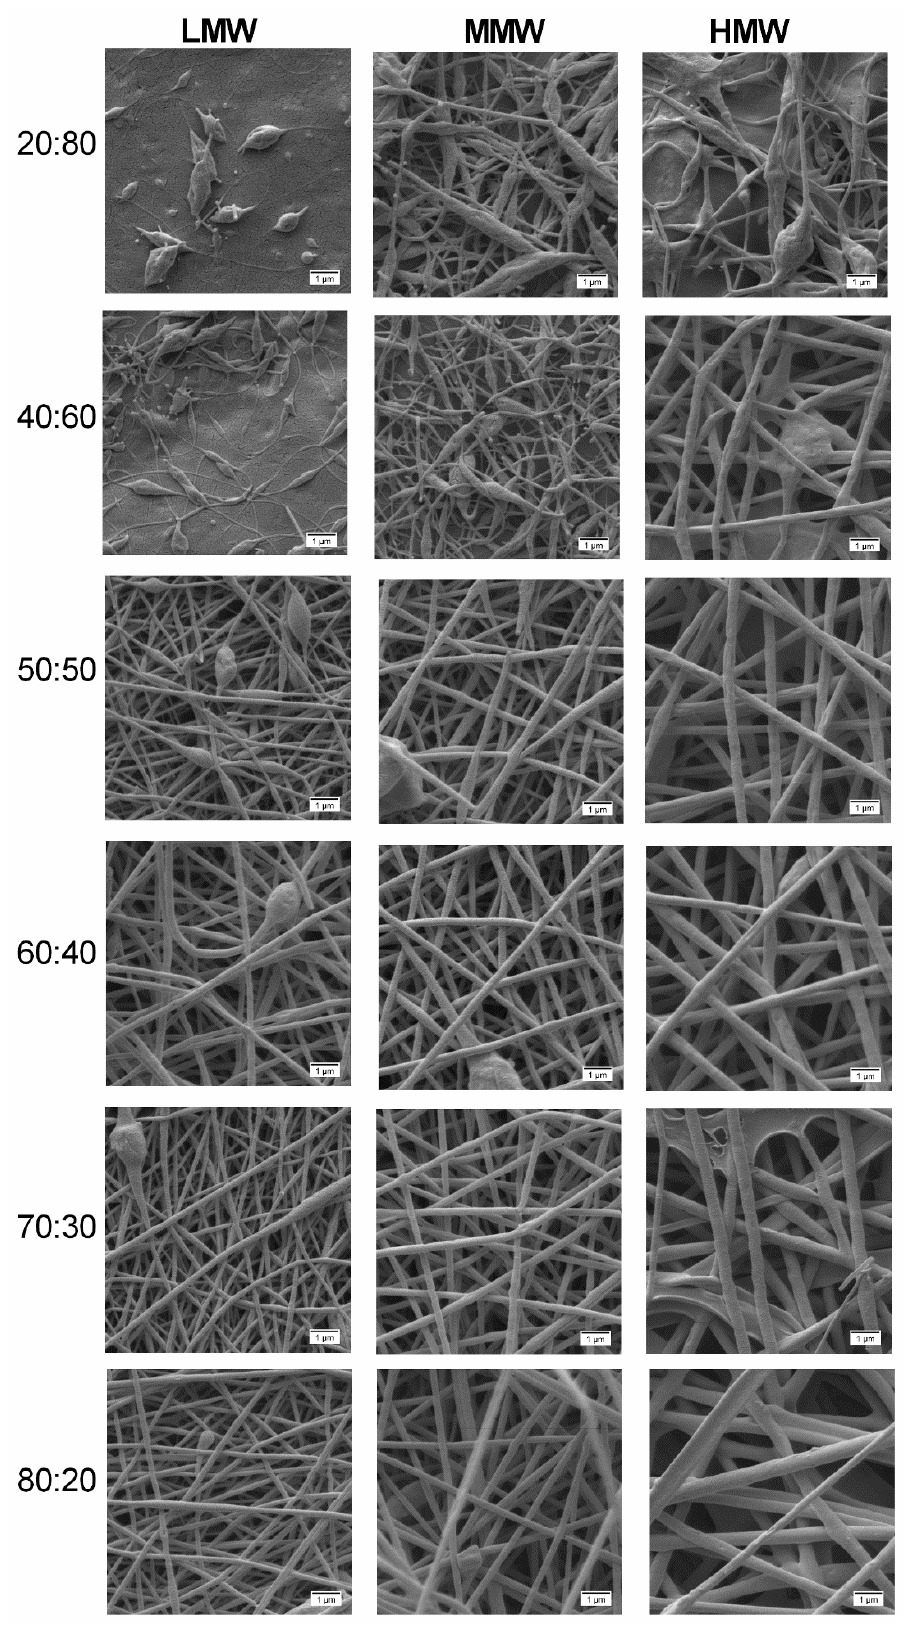
Figure 7. SEM morphologies at 10,000 × of electrospun 12 wt.% PVA / colloidal dispersion fibers at different compositions and molecular weights. All scale bars represent 1 µm.